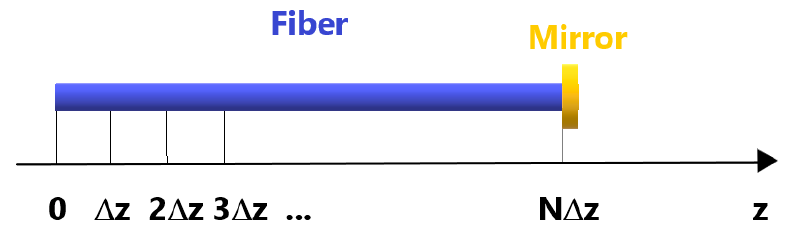
Figure 3. Schematic diagram illustrating the finite difference discretization.